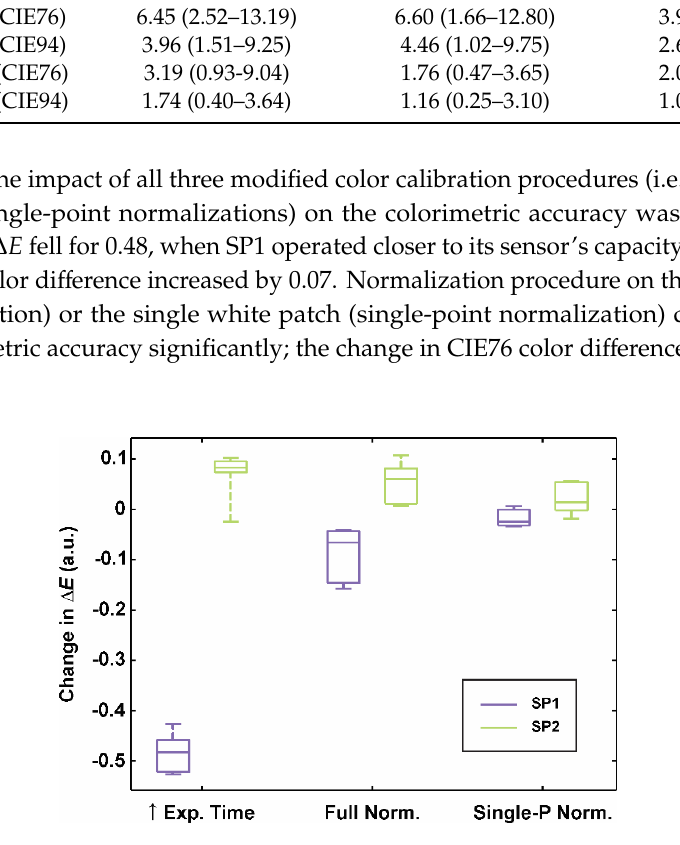
Table 1. The color di ff erence ( ∆ E ) means and the whole ranges for individual patches (in brackets) on the full- and skin-range CCTs for the first (SP1) and second (SP2) smartphone and between both smartphones (SP1-SP2, i.e., inter-smartphone variability).